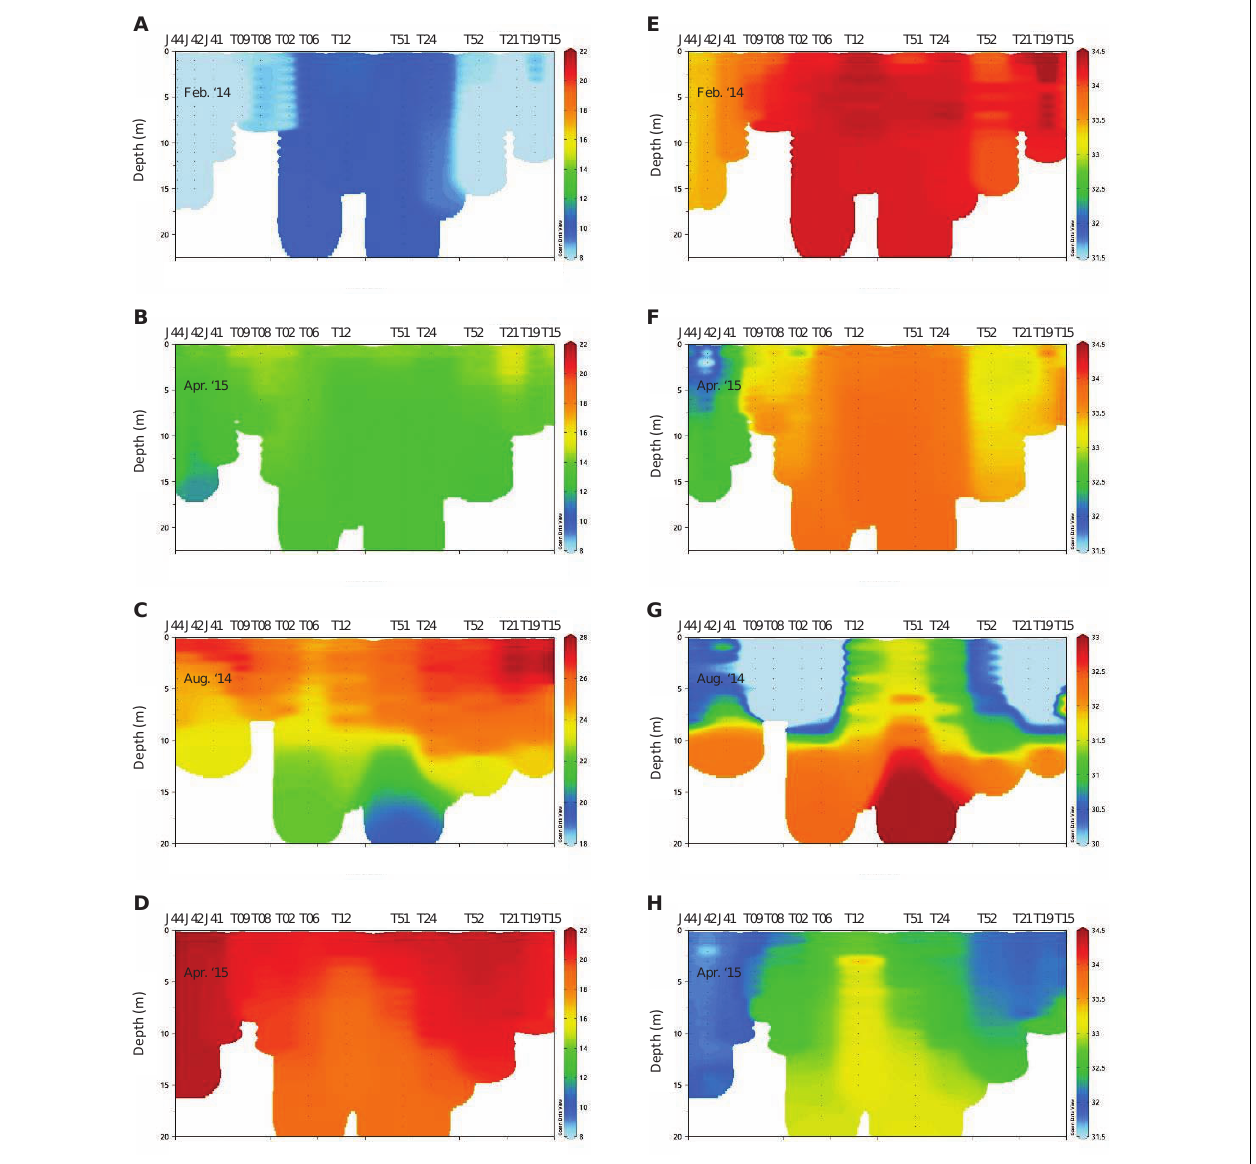
FIGURE 4 | Vertical distributions of temperature ( ◦ C) (A–D) and salinity (E–H) for each surrvey. Different ranges of scale bar were applied for August 2014. Station numbers are shown on the upper x-axis and those locations are presented in Figure 1 . Stations J44–J41 generally belong to JB, stations T09–T12 to GHR, and stations T51–T15 to